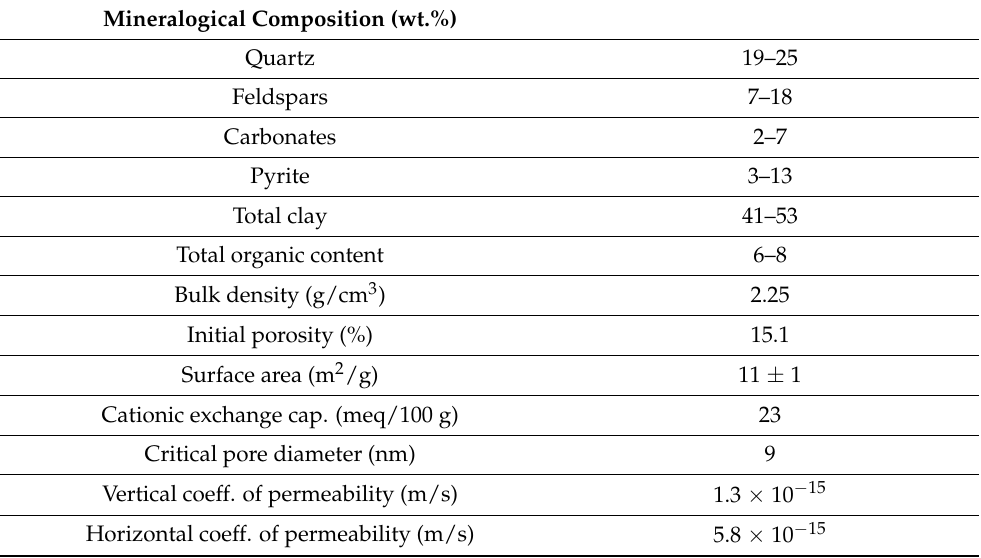
Table 1. The mineralogical composition and selected index properties of the Draupne shale used in the current study